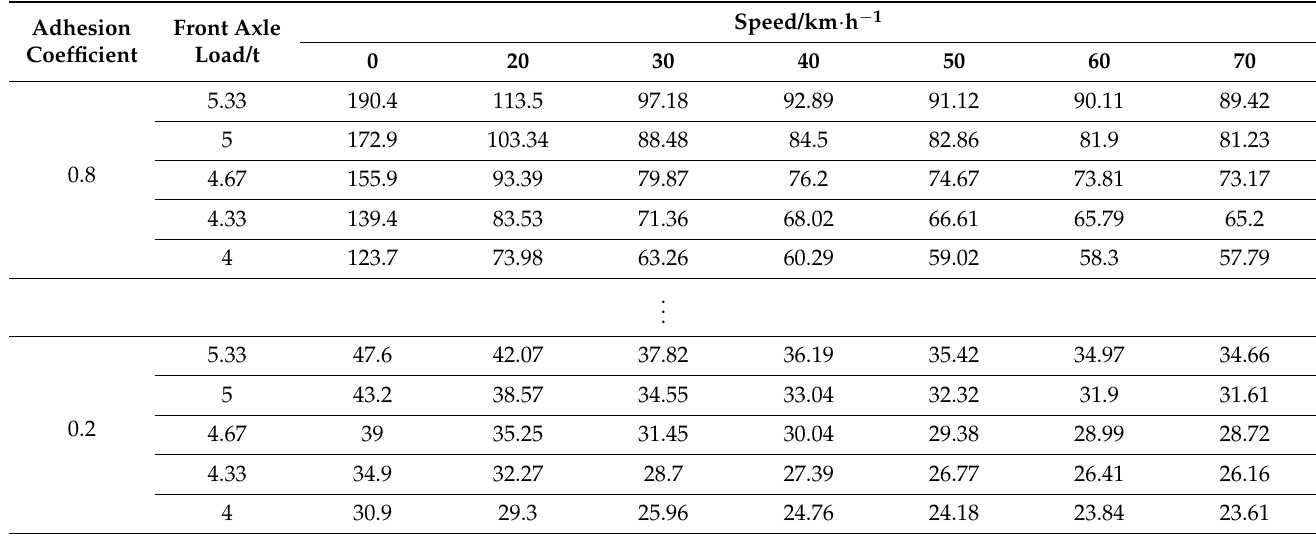
Table 1. Steering resistance torque at different front axle loads, adhesion coefficients, and vehicle speeds/(N · m).